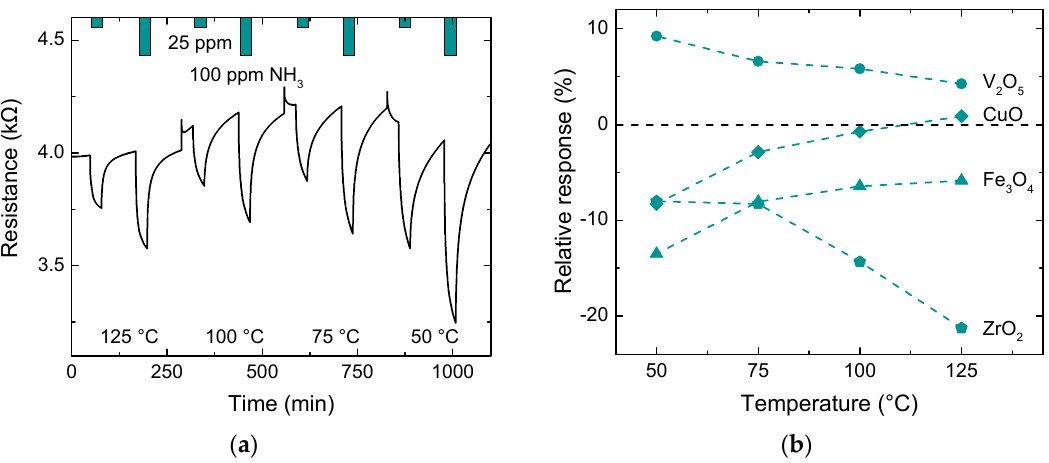
Figure 3. ( a ) Resistance over time of Fe 3 O 4 NL decorated epitaxial graphene (DEG) vs. 25 and 100 ppm NH 3 at different operating temperatures at 50% relative humidity (RH) and ( b ) relative responses of NL DEG samples for 25 ppm NH 3 exposures at different operating temperatures at 50% RH.